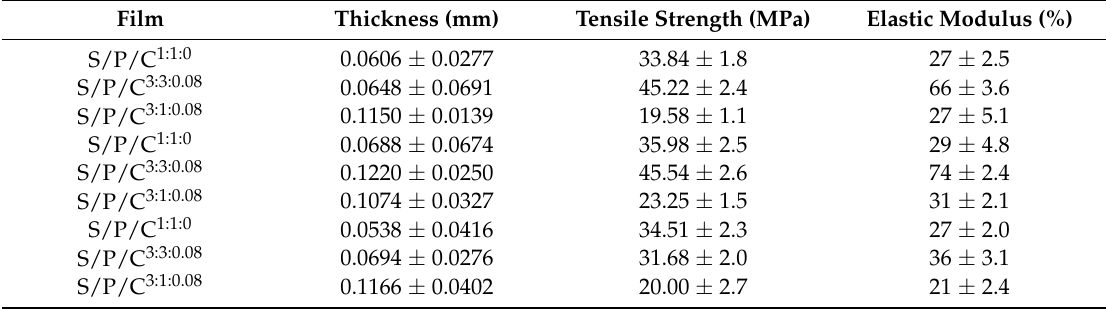
Table 3. Tensile properties of starch/polyvinyl alcohol/citric acid ternary blend functional food packaging